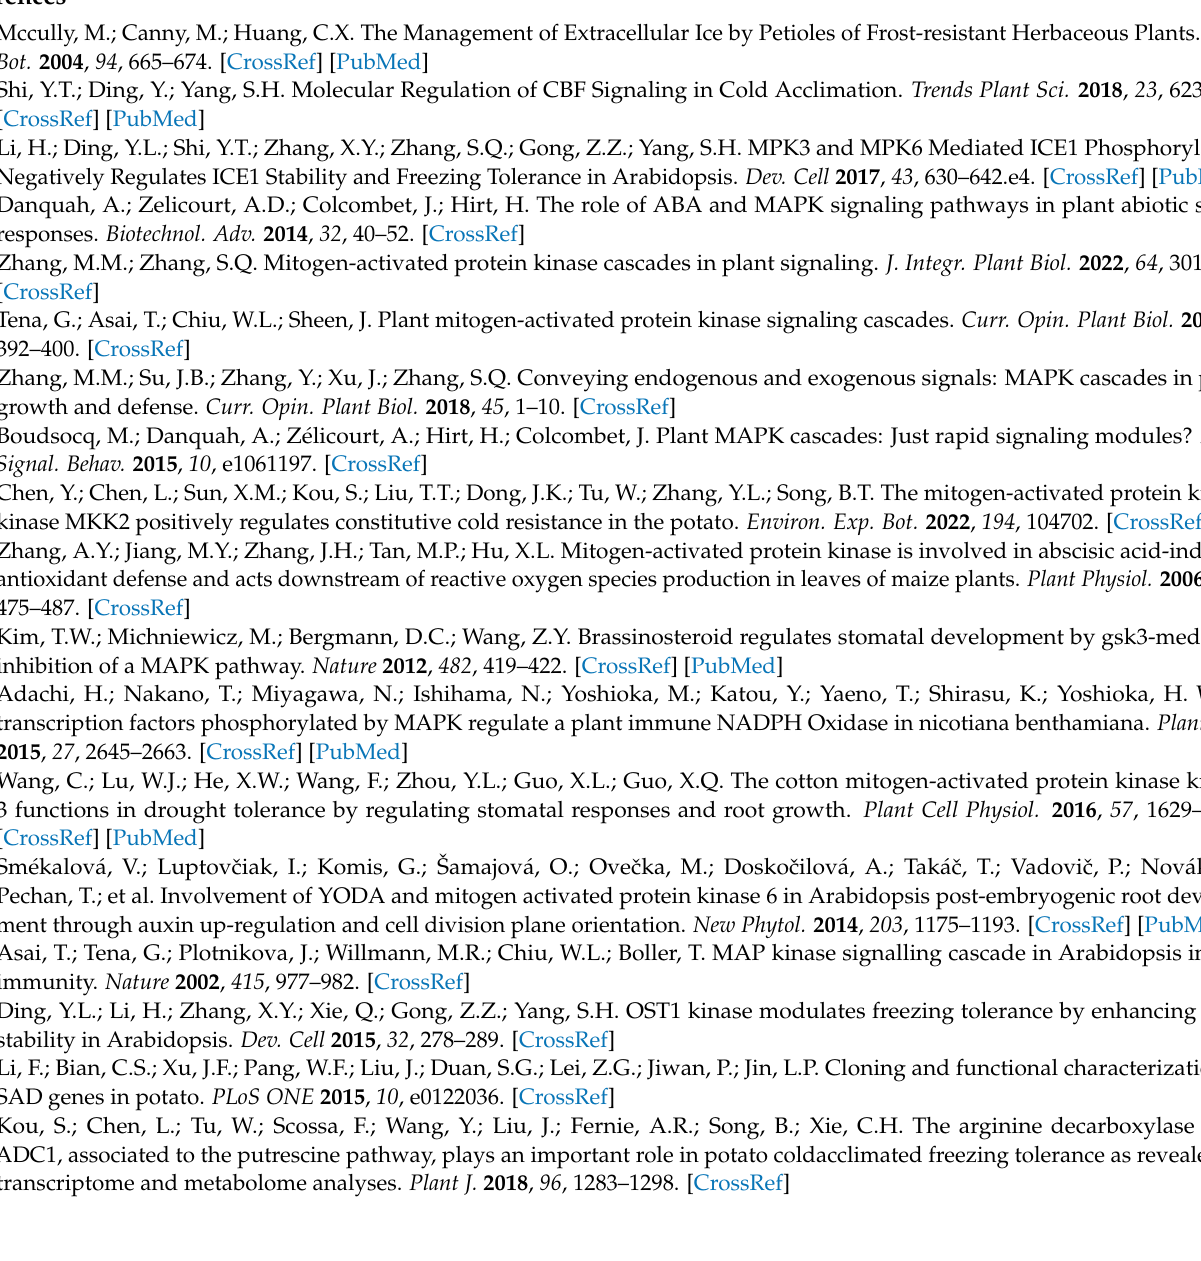
Table S2: MAPK and MAPKK family gene in potato; Table S3: The cis-elements responsive to stresses and hormones in the promoter regions of StMAPK and StMAPKK genes; Table S4: Physical and Chemical Properties of StMAPK and StMAPKK